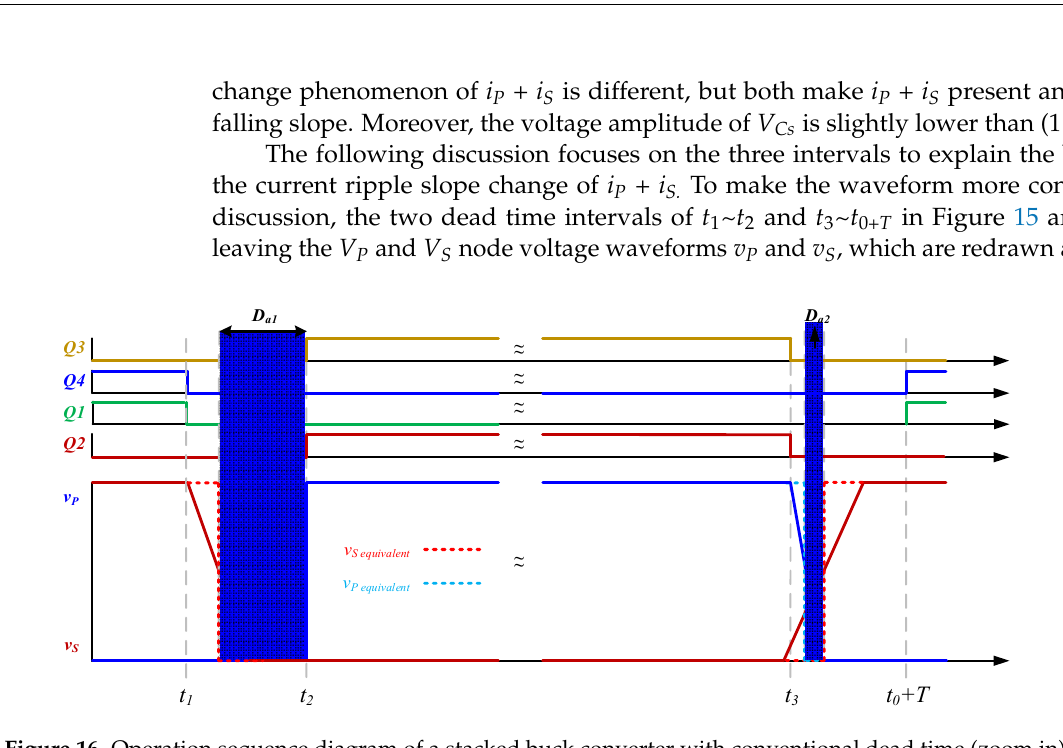
Figure 16. Operation sequence diagram of a stacked buck converter with conventional dead time (zoom in). First, we discuss the dead time interval ( t 1 ~t 2 ).